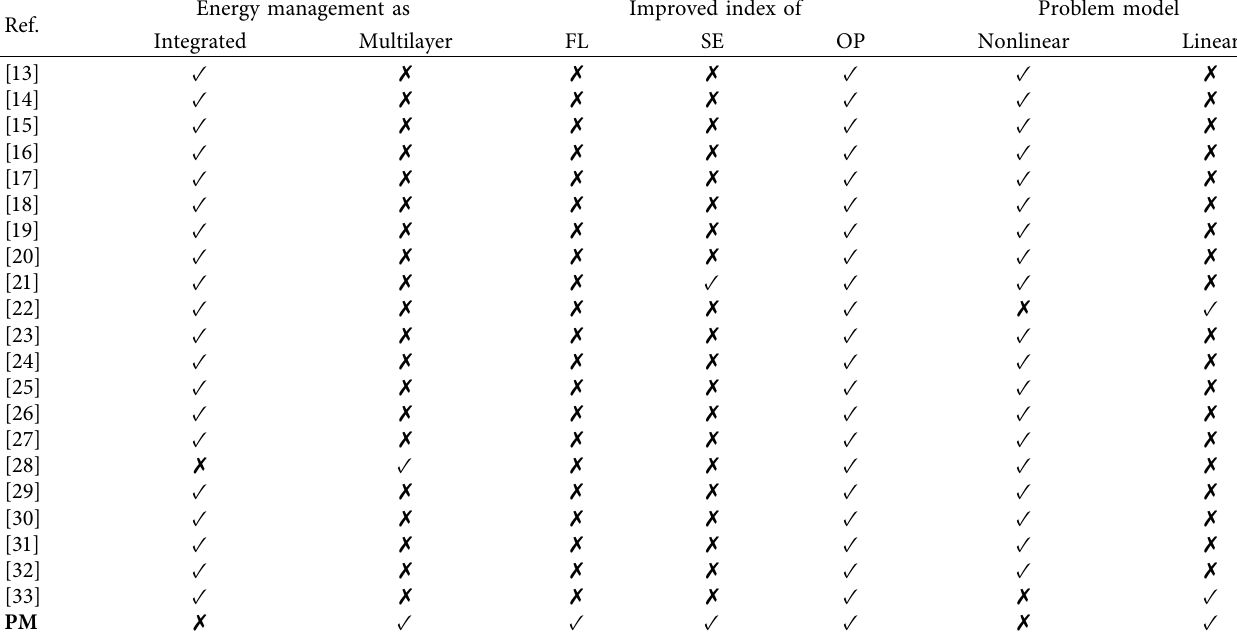
Table 1: Taxonomy of recent research works.